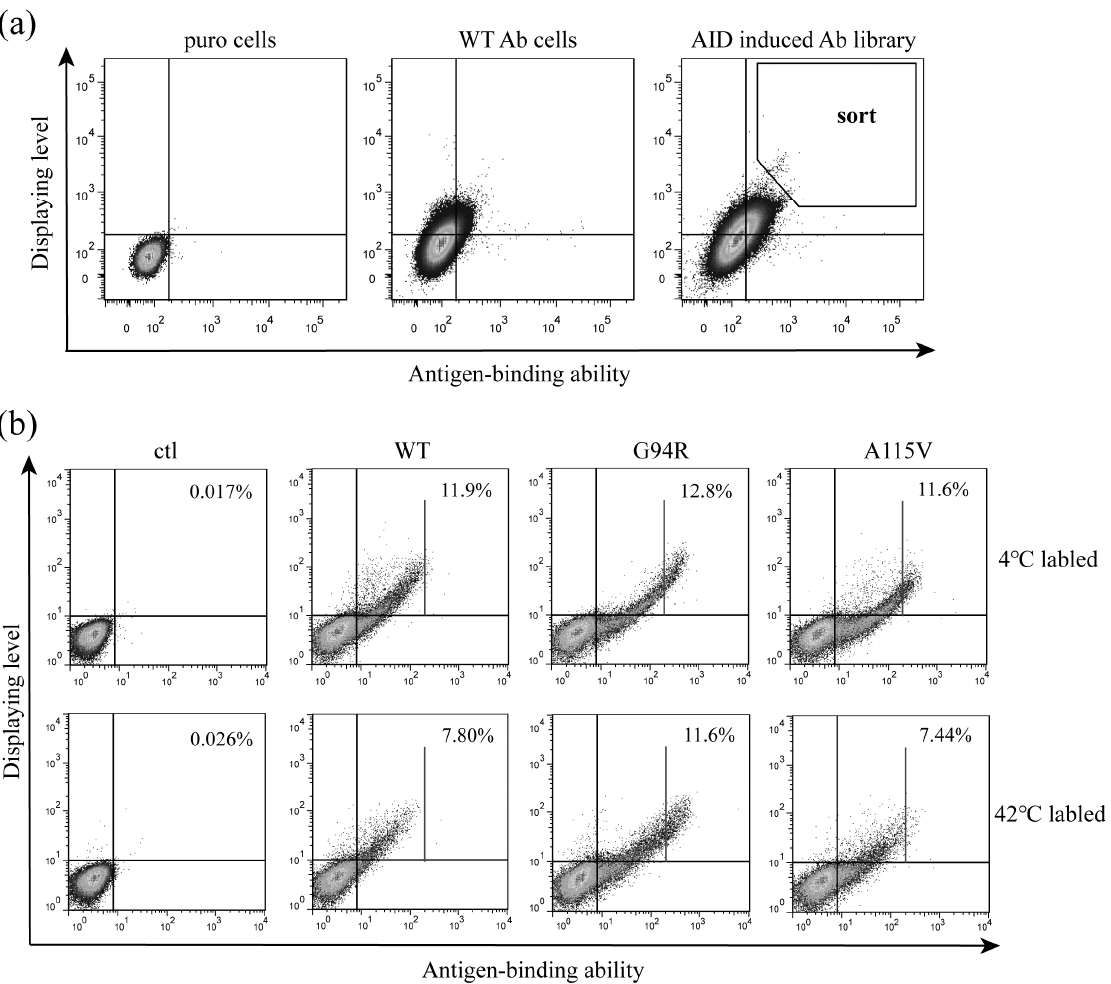
Figure 5. Stability and affinity maturation of anti-TNF α antibody. ( a ) Antibody maturation using TR cells. The maturation was conducted by following the procedure demonstrated in Figure 2. The sorting gate was set to collect the cells with the highest antigen binding and the highest displaying level ability (the top 0.01%). Two rounds of sorting were carried out in the same manner, but only the first round of sorting is shown here. ( b ) Analyses of the display levels and antigen-binding abilities of the wild-type (WT) and mutant (G94R and A115V) antibodies labeled at 4 °C and 42 °C. The assays were made on cells transiently transfected with the WT, A115V and G94R antibody genes, respectively, and then were labeled at 4 °C and 42 °C before flow cytometric analysis.